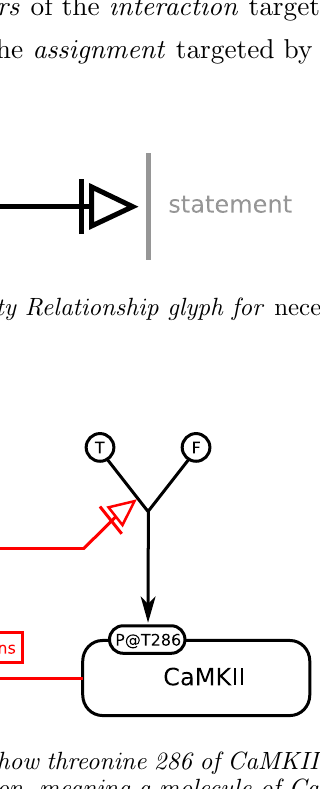
Figure 2.26: This example shows how threonine 286 of CaMKII is only phosphorylated by the kinase itself, but in a trans-fashion, meaning a molecule of CaMKII does not phosphorylate itself, but another molecule of